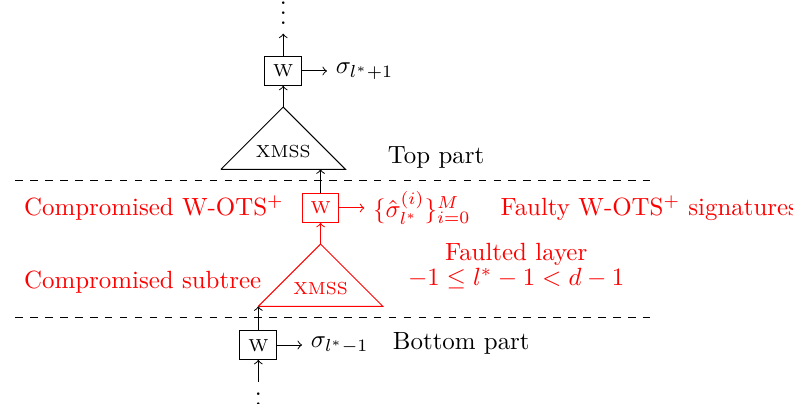
Figure 4: Terminology used throughout the description of the